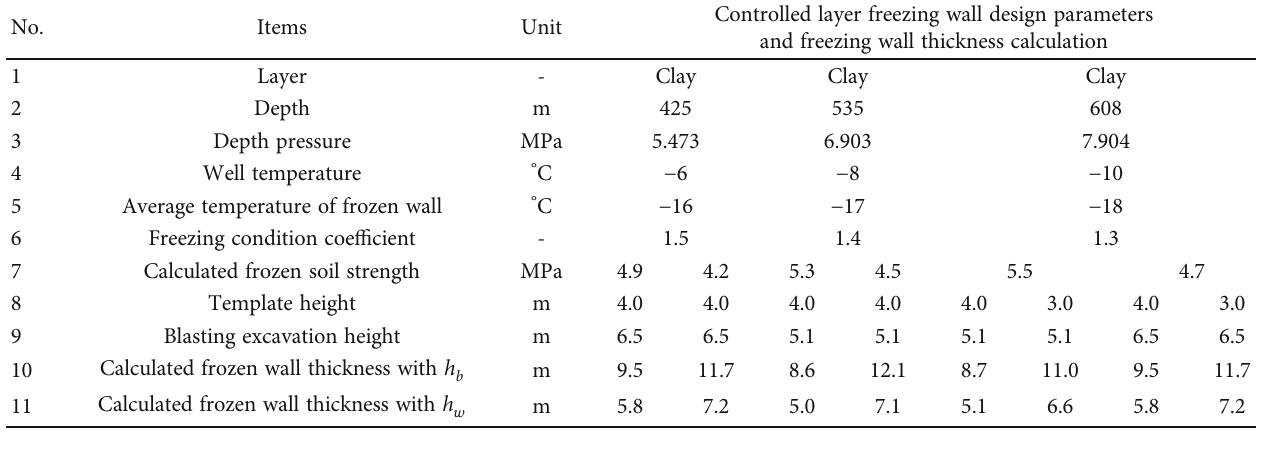
Table 3: Calculation results of the frozen wall thickness in the controlled horizon of the cohesive soil layer in west air shaft of Zhaogu No. 2 Mine.